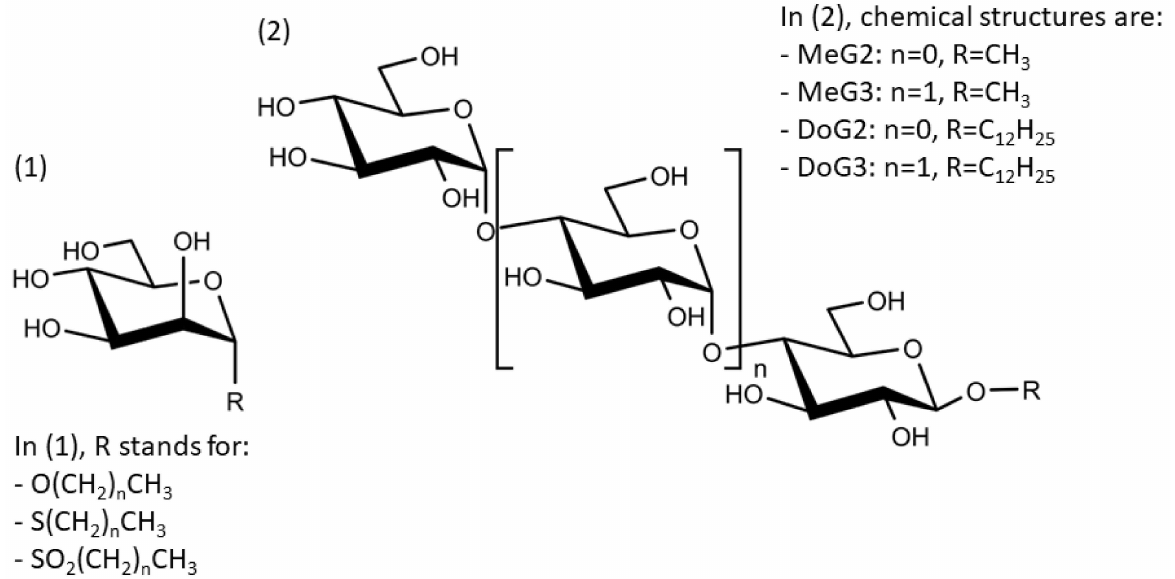
Figure 3. (1) D-mannosides as tested by Bilkov à et al. (2015) with R standing for either an O-glycosidic (O(CH 2 ) n CH 3 ), S-glycosidic (S(CH 2 ) n CH 3 ) or sulfonyl (SO 2 (CH 2 ) n CH 3 ) linkage. The alkyl chain length ranges from 6 to 20 carbon atoms [158]. (2) Alkyl- β -O-oligomaltosides as tested by Marçon et al. (2013) with R standing for either a methyl or dodecyl residue